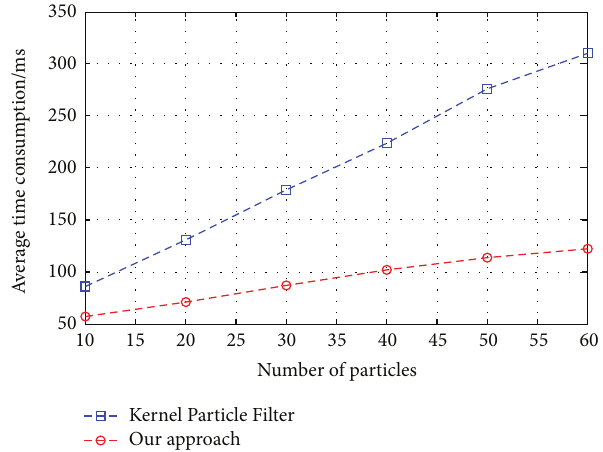
Figure 8: Comparison of the average time consumptions per frame.